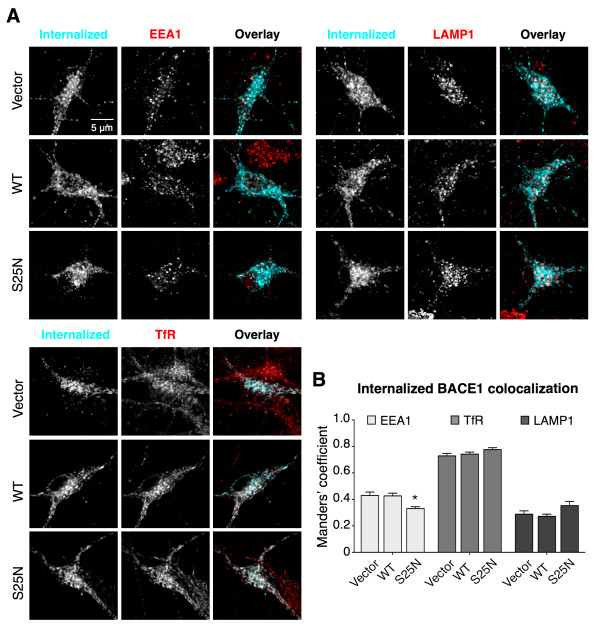
Confocal analysis of internalized BACE1 localization in the soma of cultured hippocampal neurons. (A) Representative confocal images of the cell bodies of neurons co-transfected with BBS-BACE1-YFP and the indicated mCherry-tagged Rab11b WT, Rab11S25N, or empty vector constructs. Internalized BACE1 pool was labeled by AF647-BTX uptake, and the neurons were fixed following an acid wash to remove remaining surface staining. Neurons were then immunostained with markers of early endosomes (EEA1), lysosomes (LAMP1) and recycling endosomes (TfR), and analyzed by confocal microscopy. (B) The extent of colocalization between internalized BACE1 and endogenous organelle markers was quantified in the cell bodies of neurons transfected with the indicated constructs (n = 6-10 neurons each). Note that BACE1 is still able to reach TfR-positive recycling endosomes in the cell body after the overexpression of Rab11S25N.